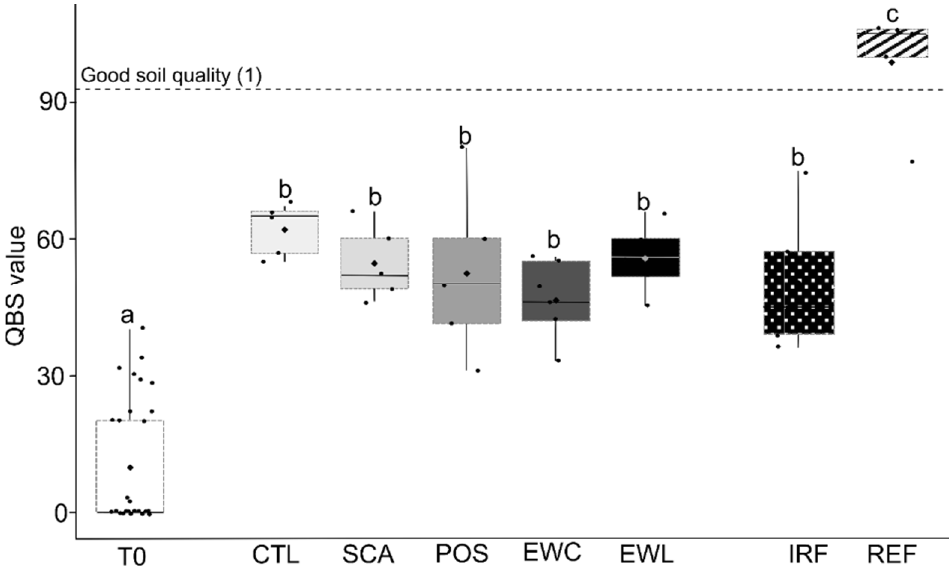
Figure 6. Boxplot of the soil biological quality results obtained using the soil biological quality index (QBS). Different letters above the bars ( a – c ) indicate significantly different values at a 95% level of significance by 1 factor ANOVA. See the Section 2 for soil restoration technique abbreviations.